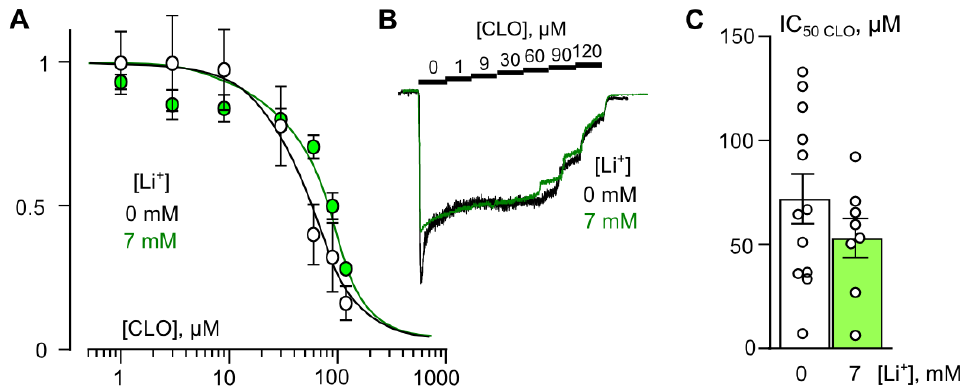
Figure 4. Extracellular lithium effect on clomipramine (CLO) inhibition of NMDAR currents in the bathing solution containing 2 mM [Ca 2+ ]. ( A ) Dependence of IC 50 for CLO inhibition of NMDAR currents on extracellular [Li + ]. Symbols show mean values ± S.E.M of the relative amplitudes of currents (I b /I c ) in the presence (I b ) and absence (I c ) of different CLO concentrations ([CLO]). Solid lines